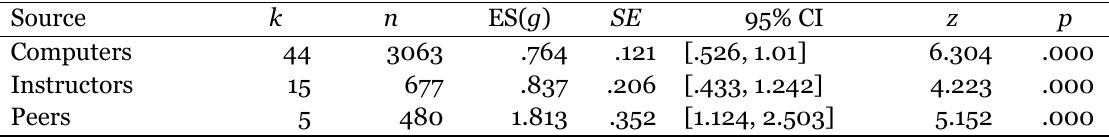
Effect Sizes of Scaffolding Sources on Learning